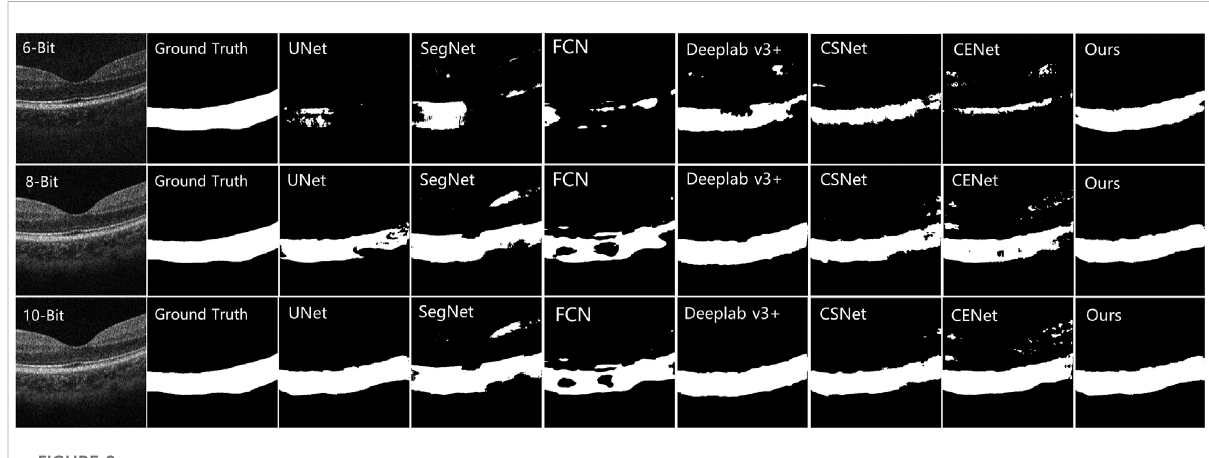
FIGURE 8 Comparisonresultsofotherchoroidsegmentationmethodsinboundarydetection.Thespeci fi cmethodsaremarkedintheupperleftcornerof the image.